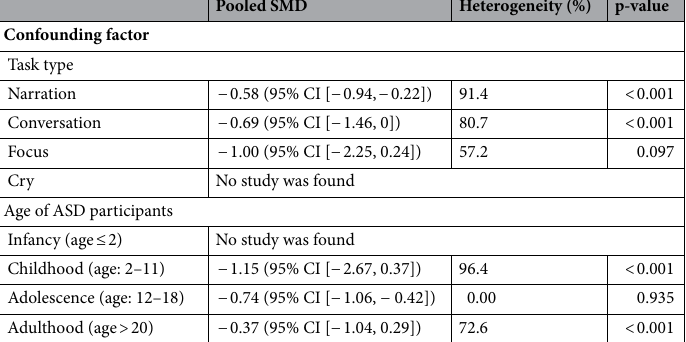
Pooled SMD Heterogeneity (%) p-value Confounding factor Task